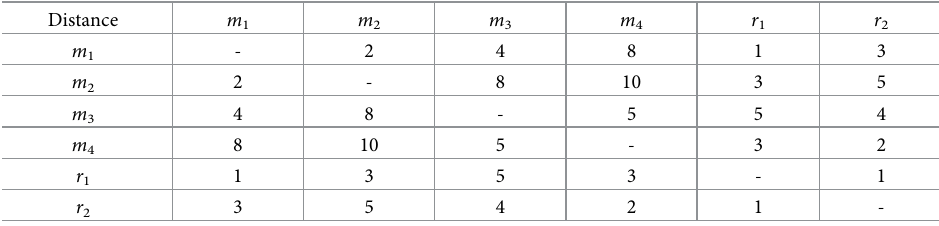
r 2 - Specifies the delivery distance between each store and the order. The delivery distances in the examples are all derived from this.